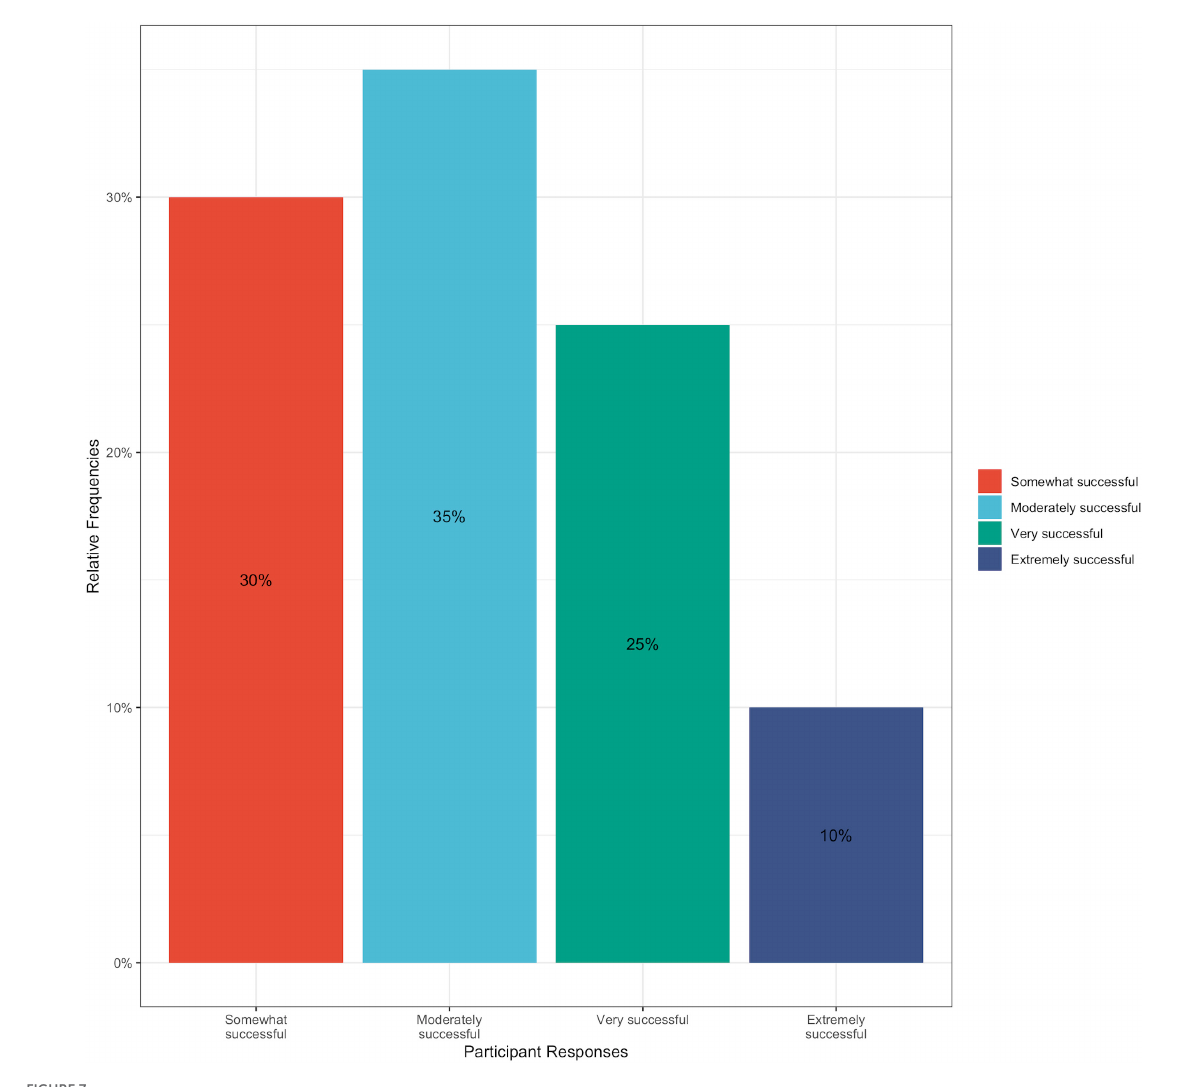
FIGURE7 Bar graph of percentage of participant responses to post-intervention survey question: Thinking about the past 3 weeks, how successful would you say you have been in achieving dietary change? Answer choices included: Extremely successful, very successful, moderately successful, somewhat successful, and not at all